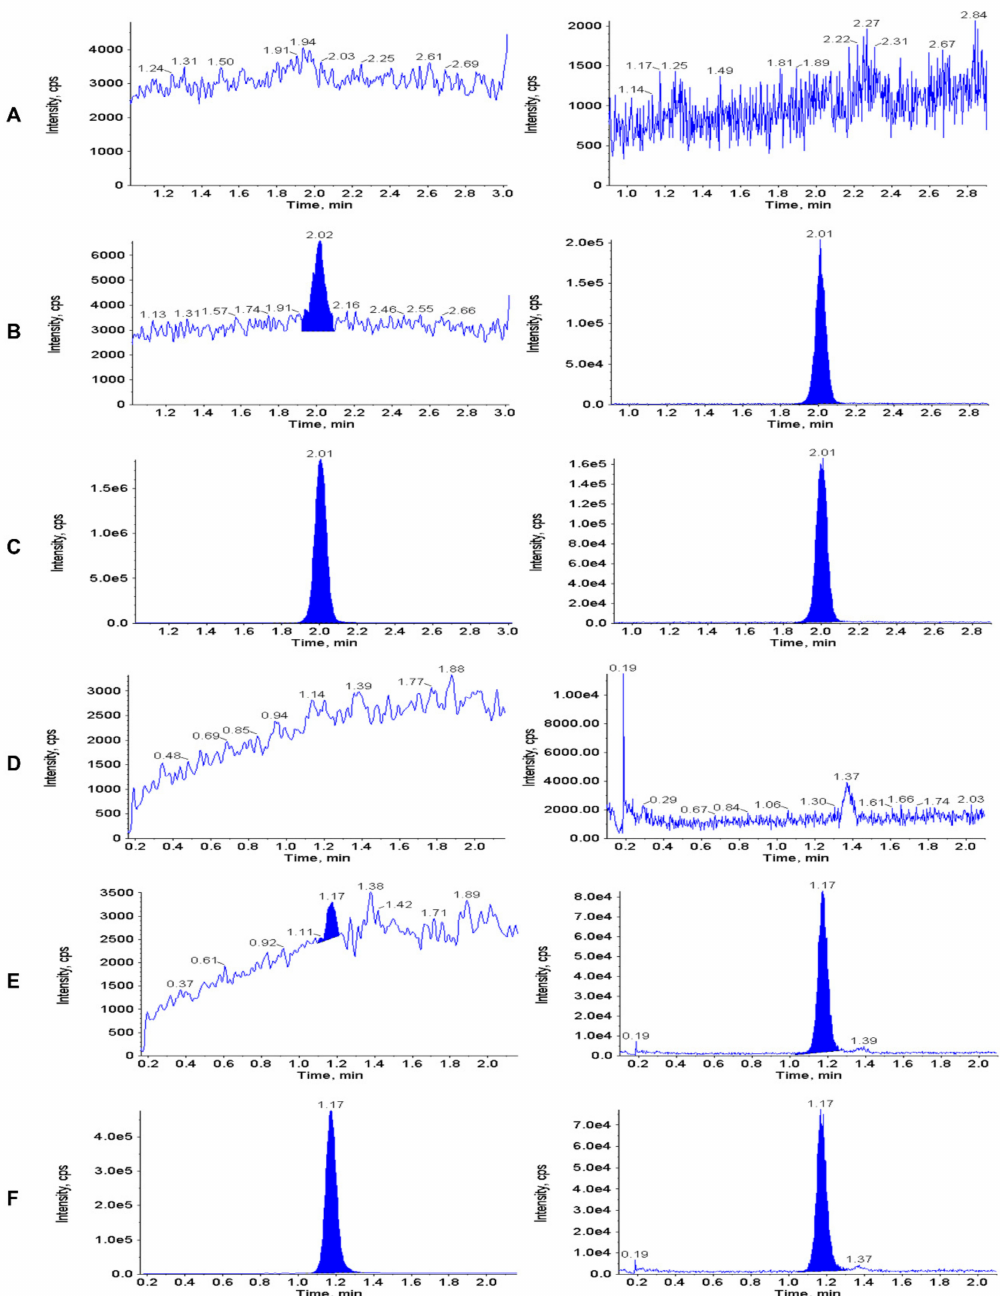
Figure 2. Representative chromatograms of extracted double blank plasma ( A and D —0 ng / mL i.e. no analyte or IS), and plasma samples spiked with thymidine and 2’-deoxyuridine at the LLOQ ( B and E —10 ng / mL) and upper limit of qualification ( C and F —10,000 ng / mL). Thymidine: panels A , B and C ; 2’-deoxyuridine: panels D , E and F